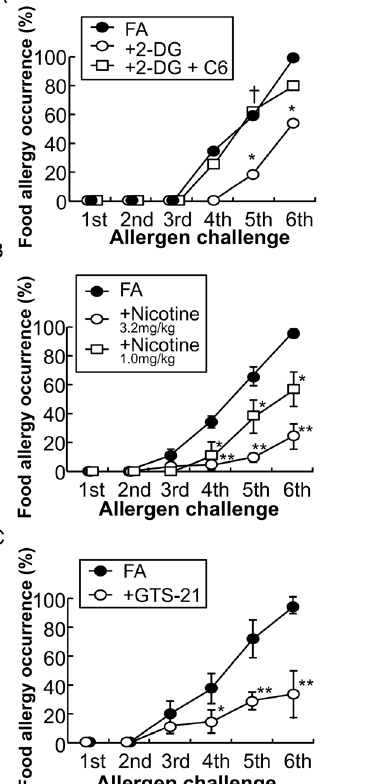
Figure 8. Cholinergic control of food allergy in mice. A : The occurrence of allergic diarrhea in FA mice (closed circle), 2-deoxy-d- glucose (2-DG)-treated mice (open circle) and hexamethonium (C6)- treated mice prior to 2-DG administration (open square) after each oral OVA challenge is shown. * P , 0.05 vs. FA mice. { P , 0.05 vs. 2-DG mice ( n =11–18 mice per group). B : The occurrence of allergic diarrhea in FA mice (closed circle) and nicotine-treated mice (3.2 mg/kg; open circle, 1.0 mg/kg; open square, and 0.32 mg/kg; open diamond) after each oral OVA challenge is shown. * P , 0.05, ** P , 0.01 vs. FA mice ( n =10–74 mice per group). C : The occurrence of allergic diarrhea in FA mice (closed circle) and GTS-21-treated mice (open circle) after each oral OVA challenge is shown. * P , 0.05, ** P , 0.01 vs. FA mice ( n =23–40 mice per group).